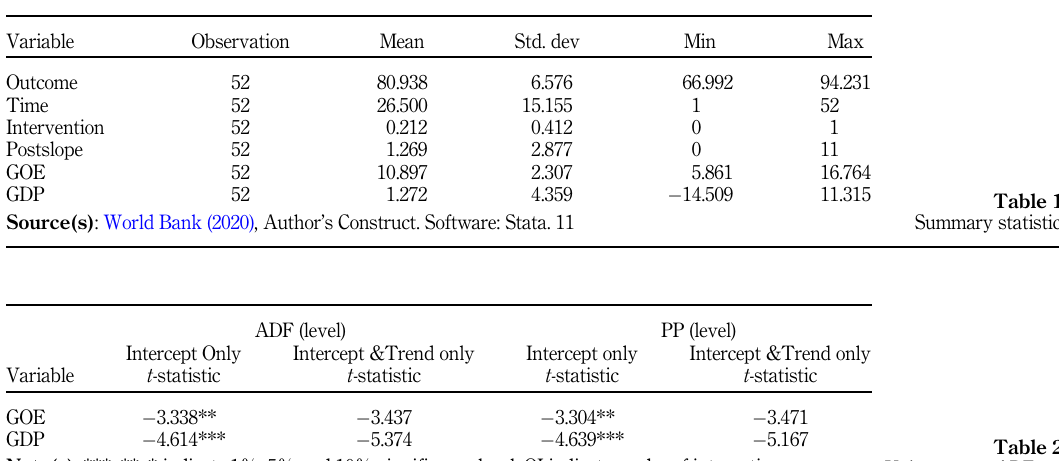
Table 2. Unit root test-ADF and